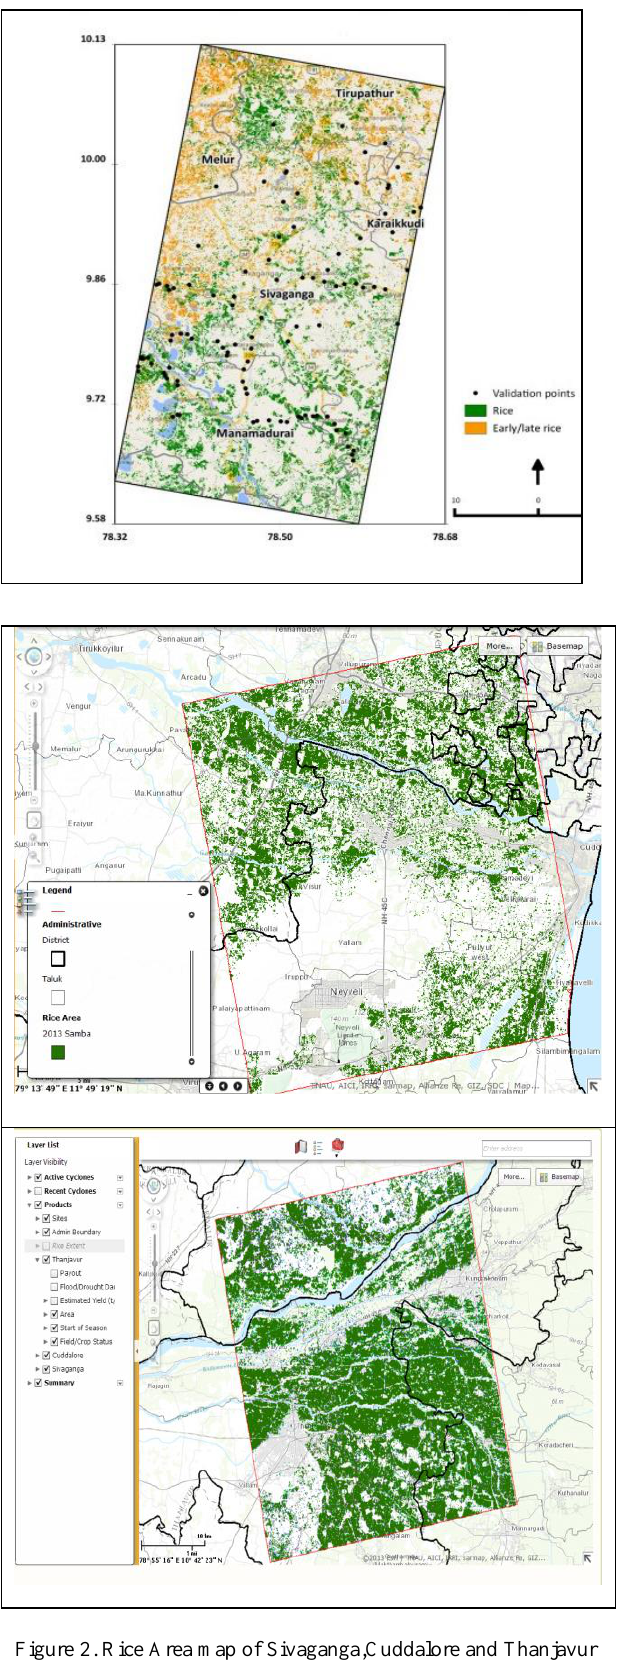
Figure 2. Rice Area map of Sivaganga,Cuddalore and Thanjavur